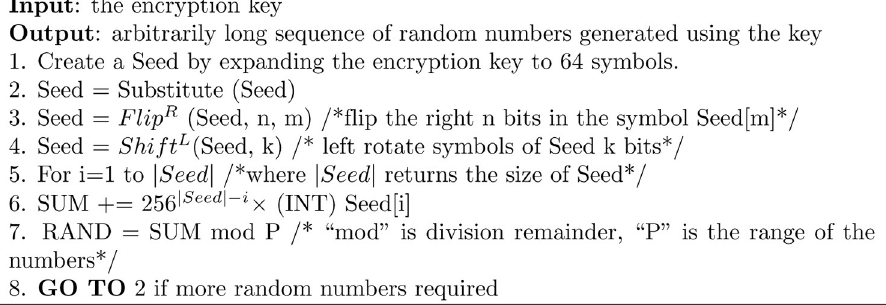
Fig 6. The algorithmic steps of the random generator.